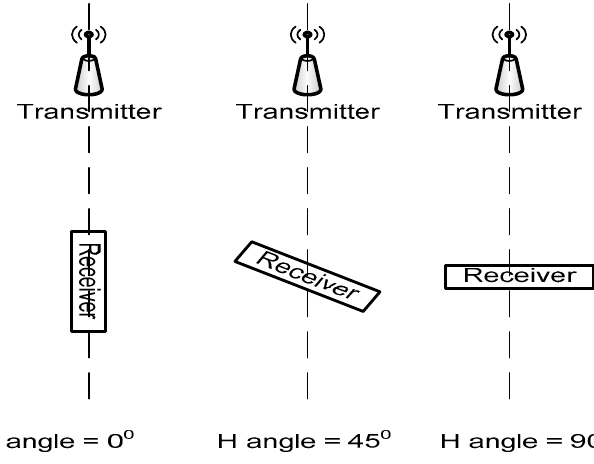
Figure 14. Angles of receiving station according to horizontal plane.